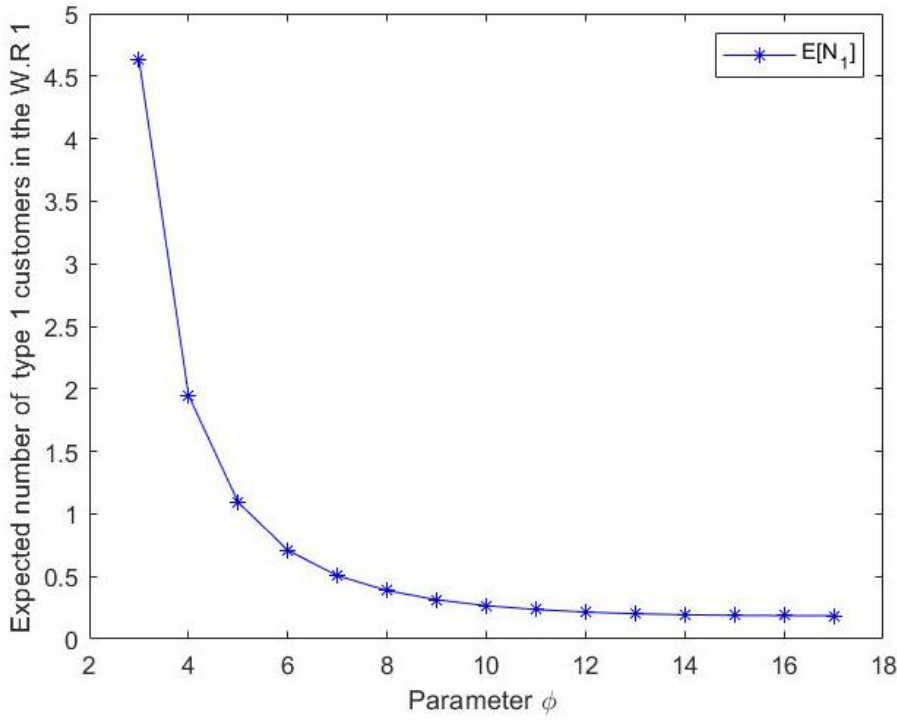
Figure 2. Effect of φ on expected number of type 1 customers in waiting room